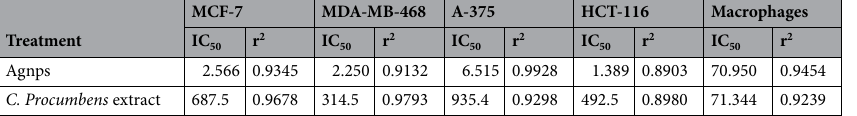
Table 2. Antiproliferative activities (IC 50 (µg/mL)) of AgNPs and C. procumbens extracts in cancer cell lines and macrophages. All the experiments were performed in triplicate.